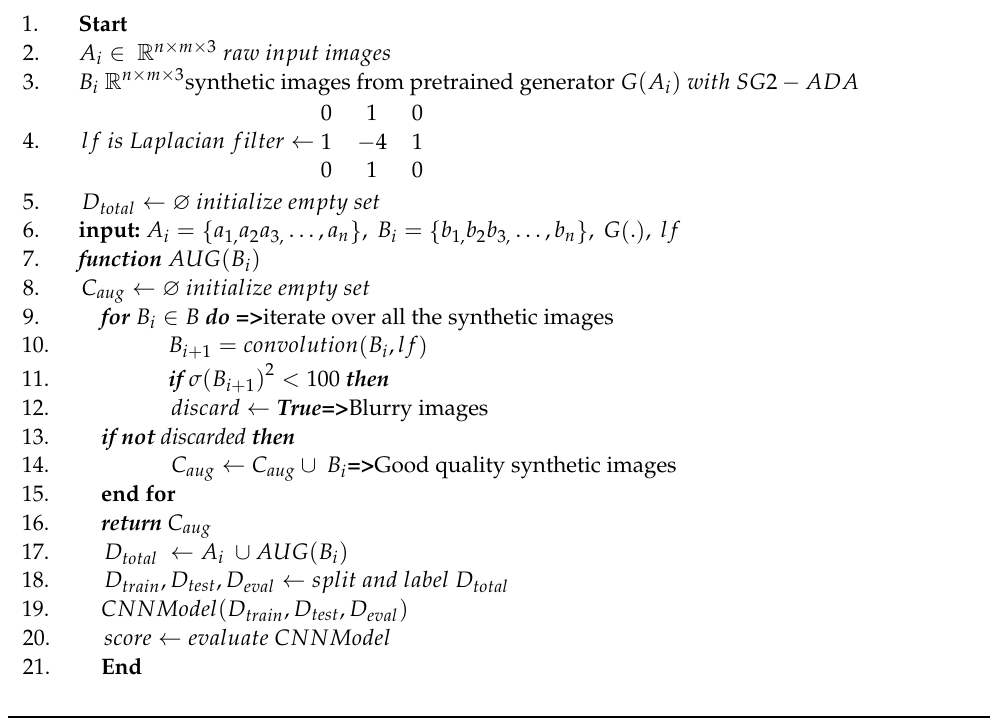
Algorithm 1 Step-by-step implementation of the proposed augmentation